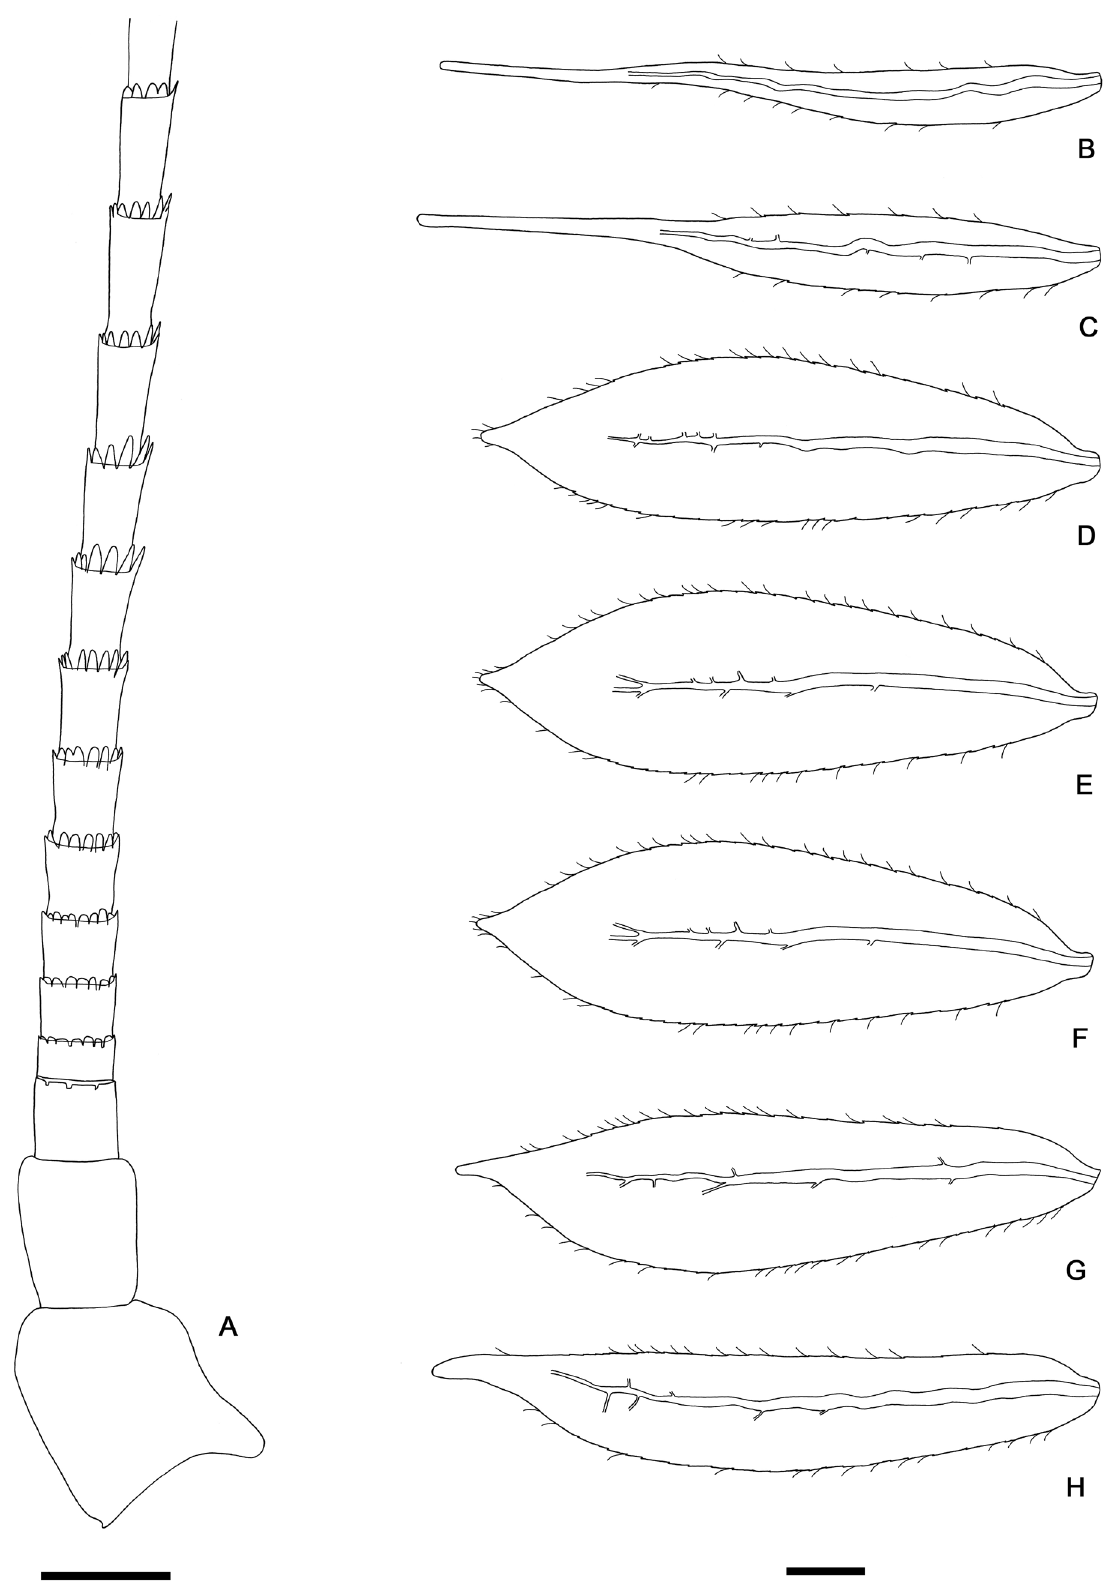
Fig. 3. Procerobaetis leptobranchius gen. et sp. nov., larval morphology. A . Antenna. B . Gill I. C . Gill II. D . Gill III. E . Gill IV. F . Gill V. G . Gill VI. H . Gill VII. Scale bars: 0.1